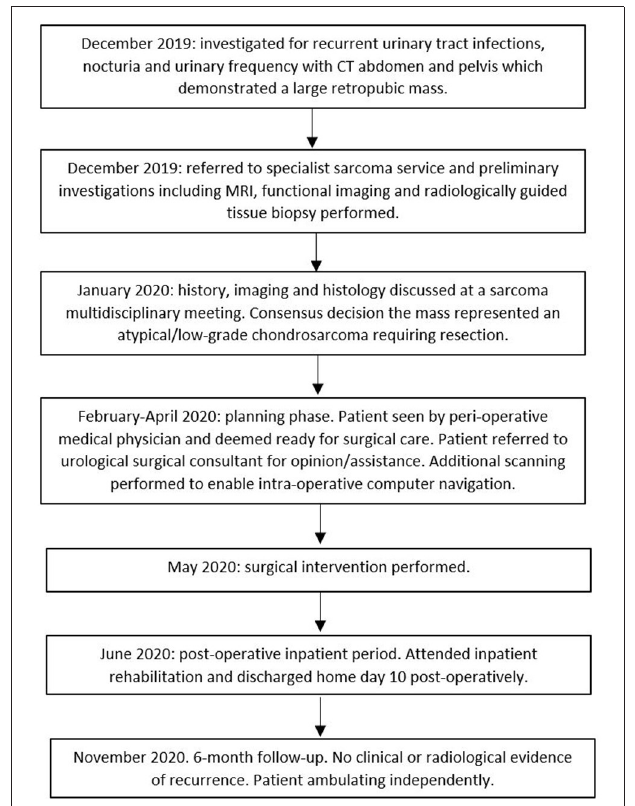
FIGURE 1 | Timeline of case